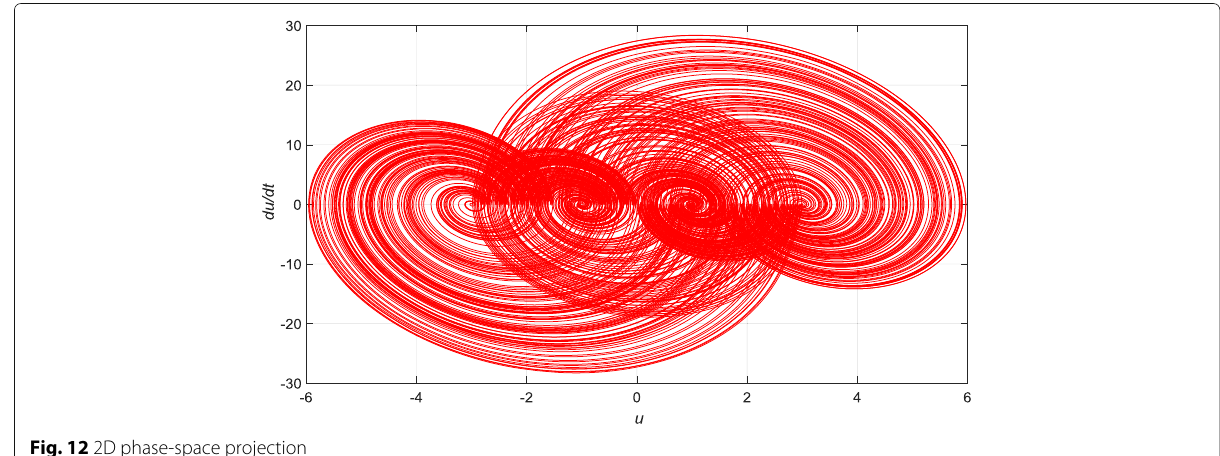
Fig. 12 2D phase-space projection